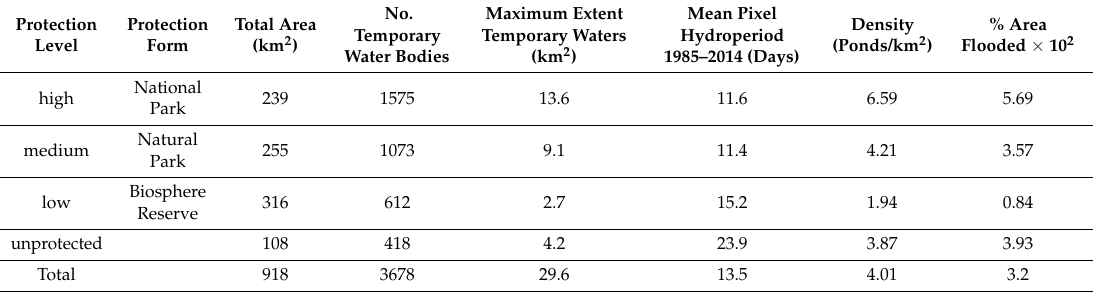
Table 1. Distribution and density of temporary water bodies in the Doñana’s aeolian sands in relation to protection level.